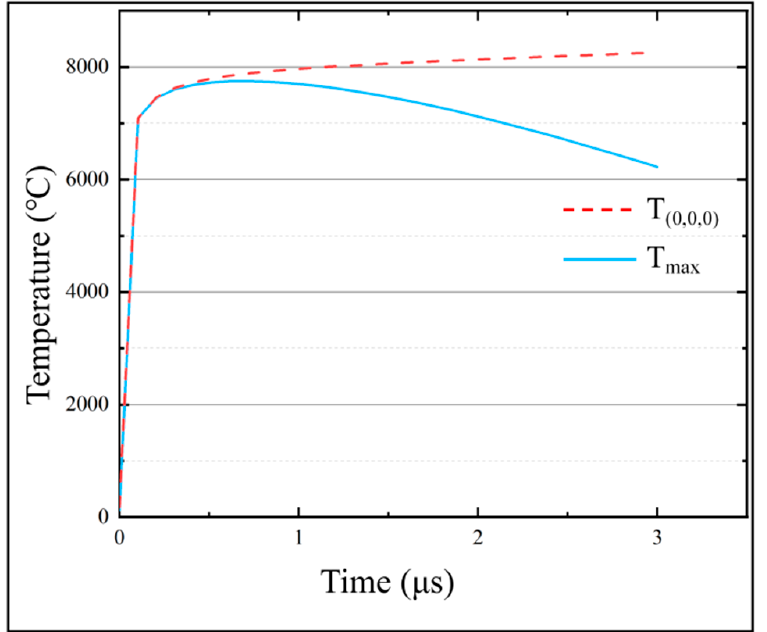
Figure 8. Variation of T max and T (0,0,0) with machining time. At the beginning of the discharge, the center of the discharge channel is at (0,0,0). Under the action of a high-frequency pulse power supply, T (0,0,0) rises rapidly. With the progress of EDM, the center of the discharge channel gradually moves away from the starting point, and the heat generated by the discharge gradually weakens against the starting point. Under this condition, T (0,0,0) begins to decrease gradually. As shown in Figure 8, the maximum temperature of the micro-bit can reach 8260 ◦ C. The melting point of YG8 cemented carbide is 2800 ◦ C. Therefore, under the effect of high temperature generated by electric discharge, the micro-bit will melt and vaporize, resulting in the EDM wear. In this paper, the temperature field of the micro-bit over its melting point is noted as V m , and V m is equivalent to the EDM wear of the micro-bit (Figure 9).